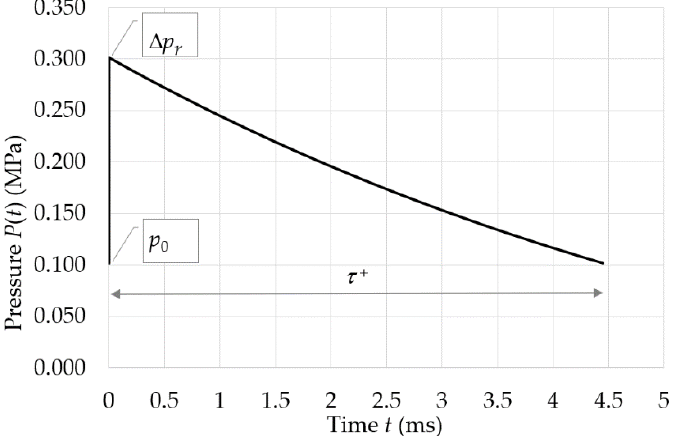
Figure 6. Variation of the overpressure with respect to time of the middle point of the sandwich panel’s external facing.